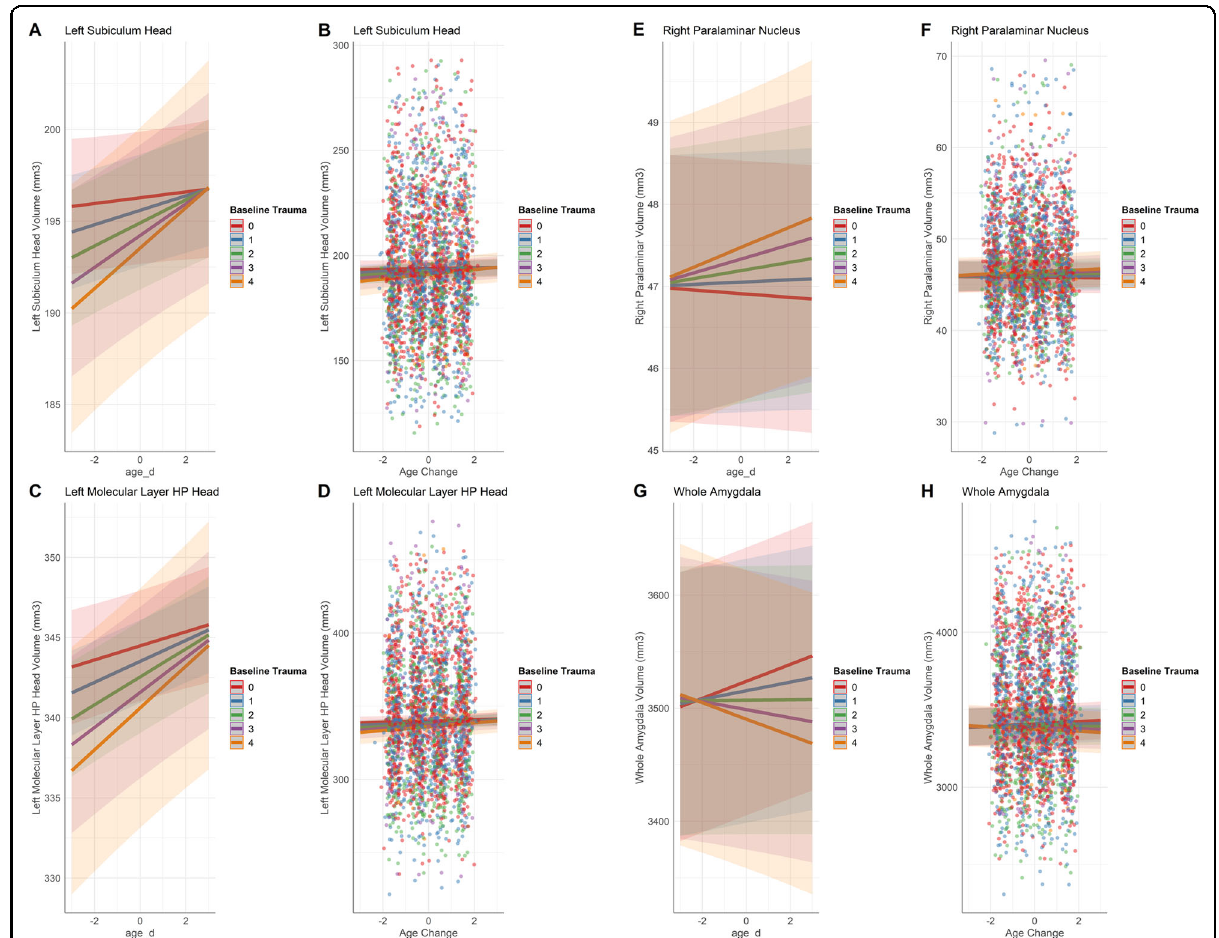
Fig. 3 Hippocampal sub fi eld and amygdala nuclei volumes predicted by the interaction between lifetime trauma at baseline and within- person age change (age_d). This interaction is represented for left subiculum head volumes ( A , B ), left molecular layer HP head volumes ( C , D ), right paralaminar nucleus volumes ( E , F ), and whole amygdala volumes ( G , H ). Individual data points represent volume measured at subject scan visits. Lines represent the categorical values of the moderator variable, number of lifetime traumatic events at